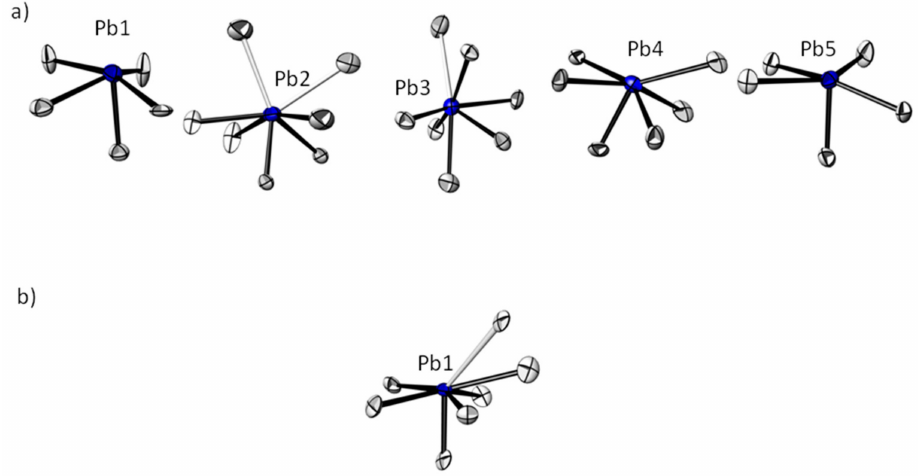
Figure 1. The coordination environments of the Pb II cations in the crystal structures of ( a ) γ -PbTeO 3 and ( b ) β -PbTeO 3 . Pb–O bonds (<2.8 Å) are displayed with filled lines, longer bonds (2.8–3.6 Å) with open lines. Anisotropic displacement parameters are displayed at the 90% probability level.